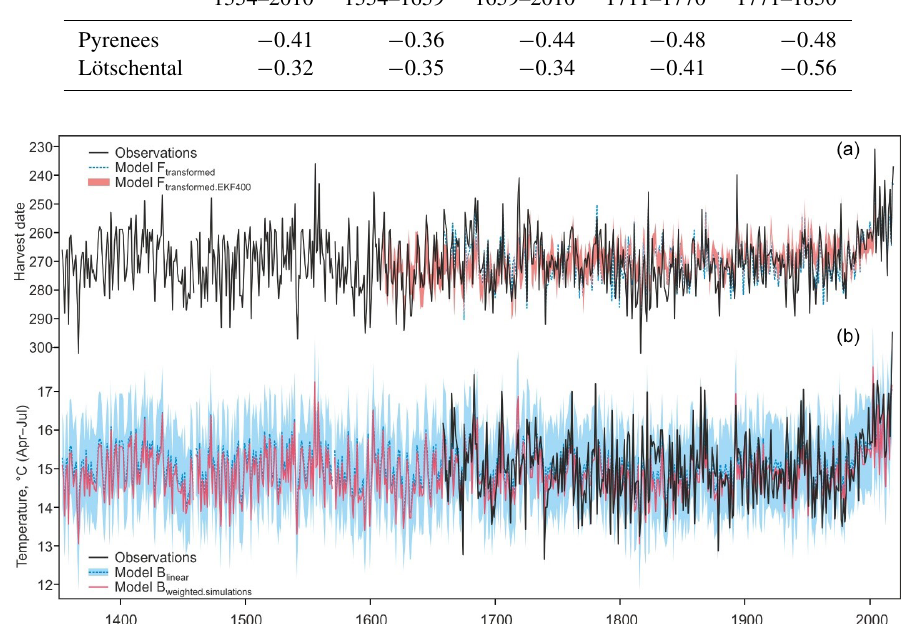
Figure 8. (a) Harvest dates in observations and modelled from observed and reconstructed (EKF400) temperatures. (b) April-to-July mean temperature from observations and reconstructed from models B linear and B weighted . simulations . Blue shading denotes the 95% prediction interval for B linear